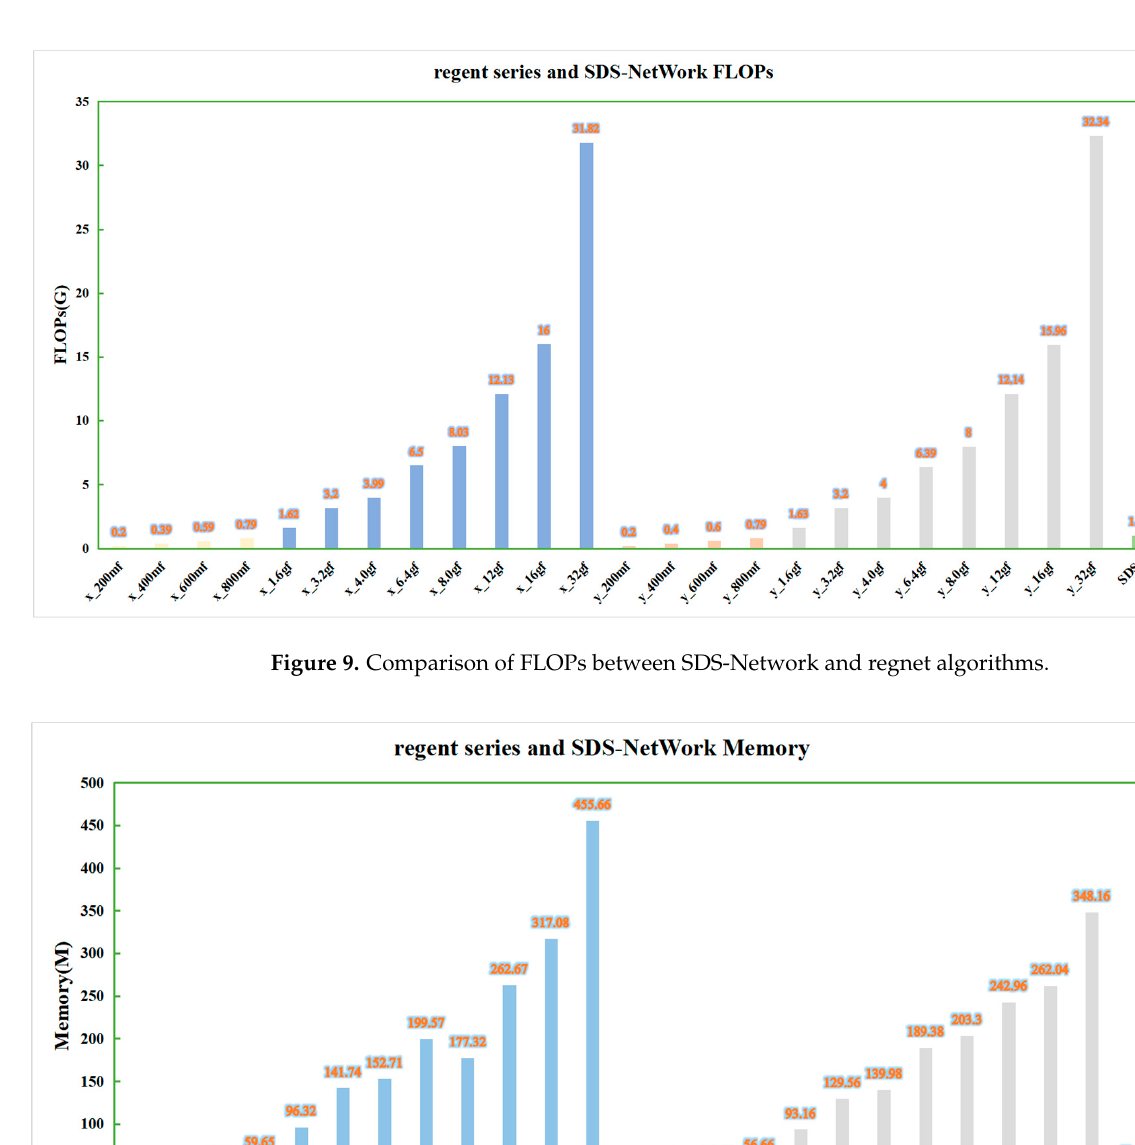
11 of 17 Figure 8. SDS-Network and regnet algorithm Acc comparison diagram. x_200mf–x_800mf are marked in yellow; x_1.6gf–x_32gf are marked in blue; y_200mf–y_800mf are marked in orange; y_1.6gf–y_32gf are marked in gray; and SDS is marked in green. It can be seen in Figure 9 that the regnetx_32gf and regnety_32gf algorithms have the